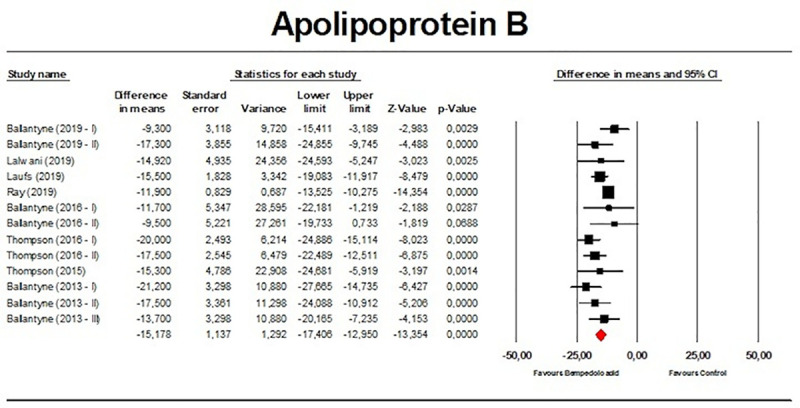
Forest plot displaying mean difference and 95% confidence intervals for the effect of bempedoic acid on plasma levels of apolipoprotein B.